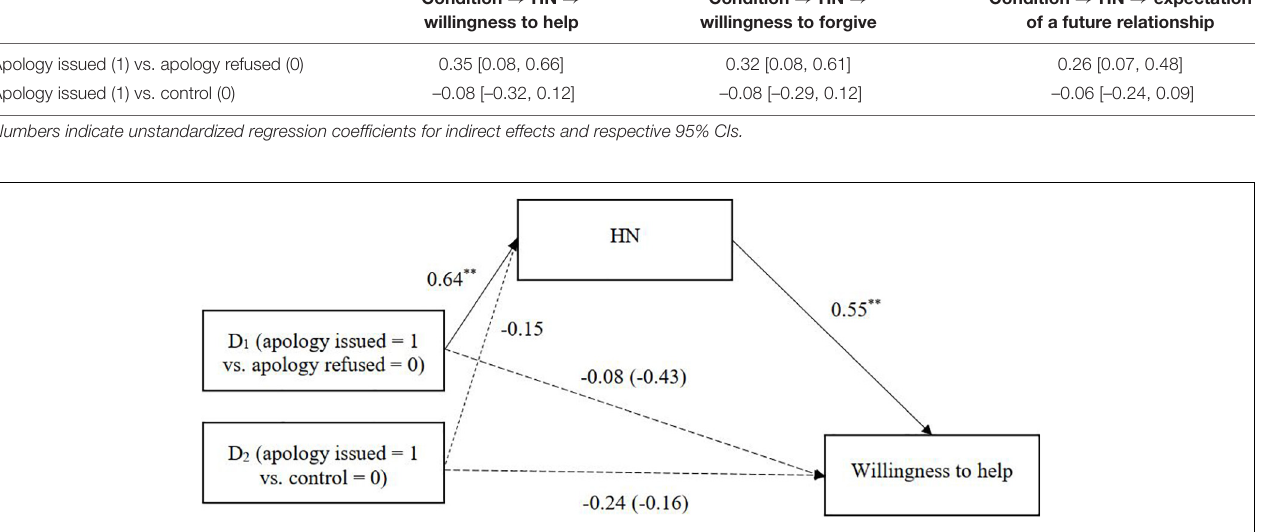
Condition → HN → Condition → HN → willingness to help willingness to forgive